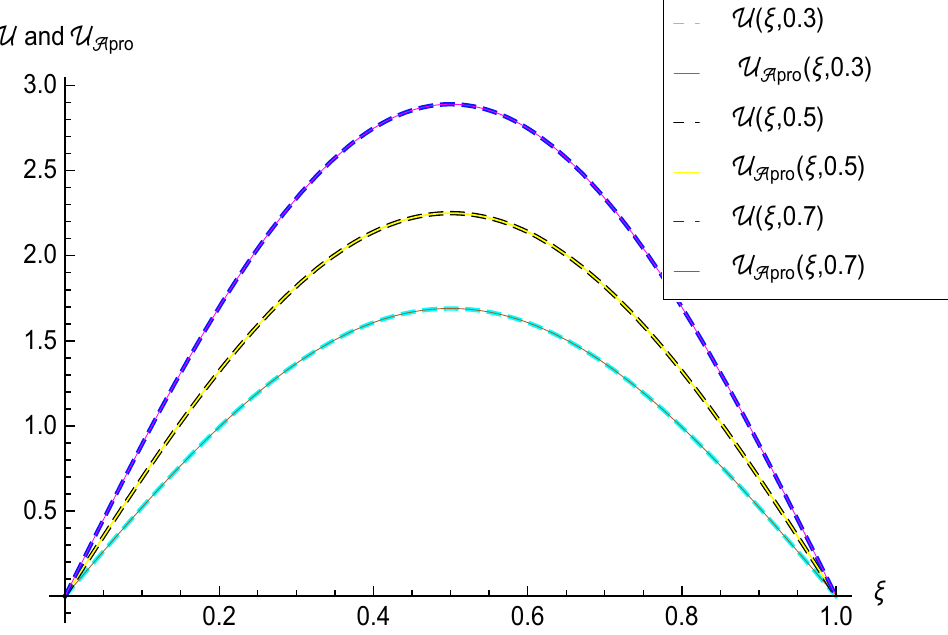
Figure 4. x -Curves of the exact and numerical solutions of U ( ξ , τ ) of the problem (30), where σ 1 = (cid:36) 1 = σ 2 = (cid:36) 2 = 0, ν = 0.5 and N = M =